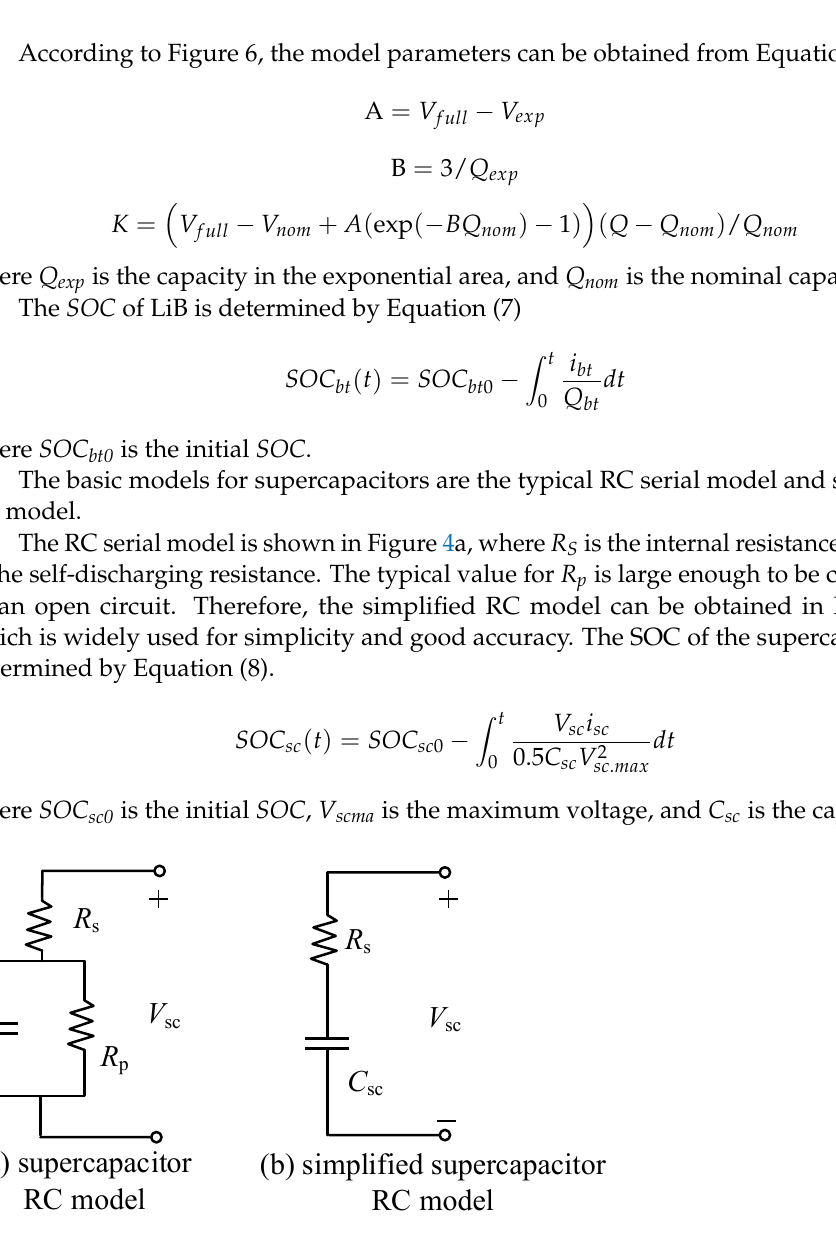
Figure 4. ( a ) Typical supercapacitor RC model and ( b ) simplified supercapacitor RC model.